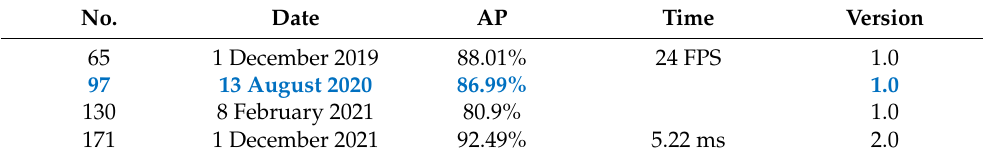
Table 8. The performance evolution of detectors on AIR-SARShip (the data come from the 177 papers).